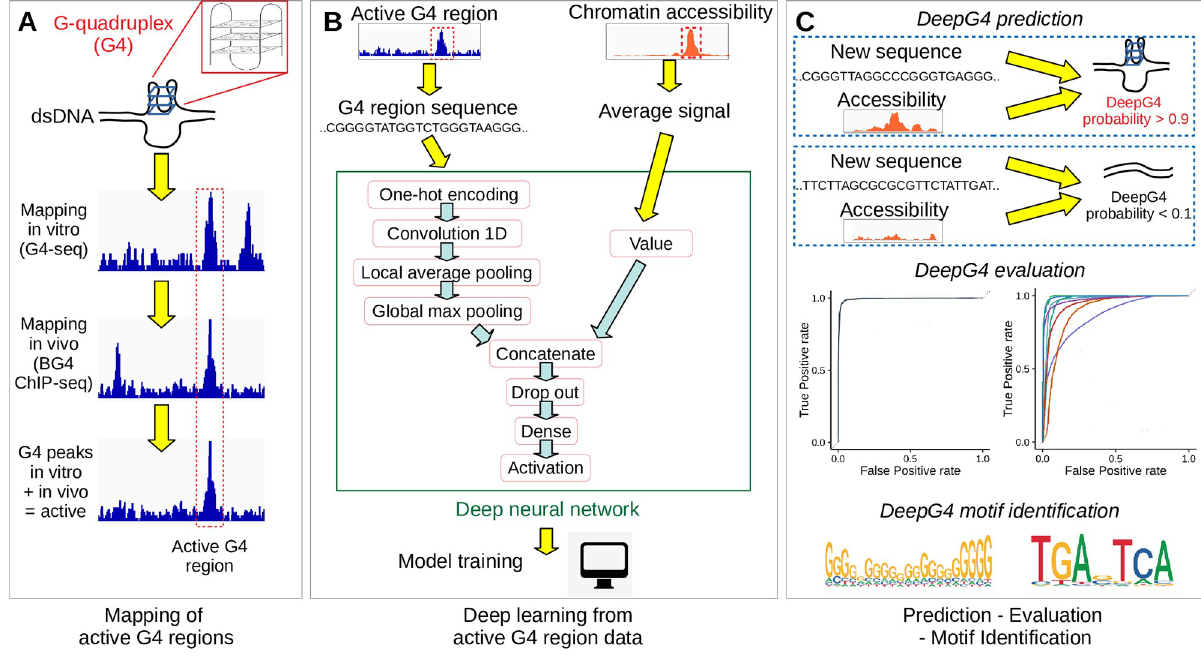
Fig 2. Illustration of DeepG4. A) Mapping of active G4 region sequences both in vitro and in vivo using NGS techniques. B) Deep learning model training using active G4 regions and control sequences. C) G4 activity prediction, evaluation and motif identification.